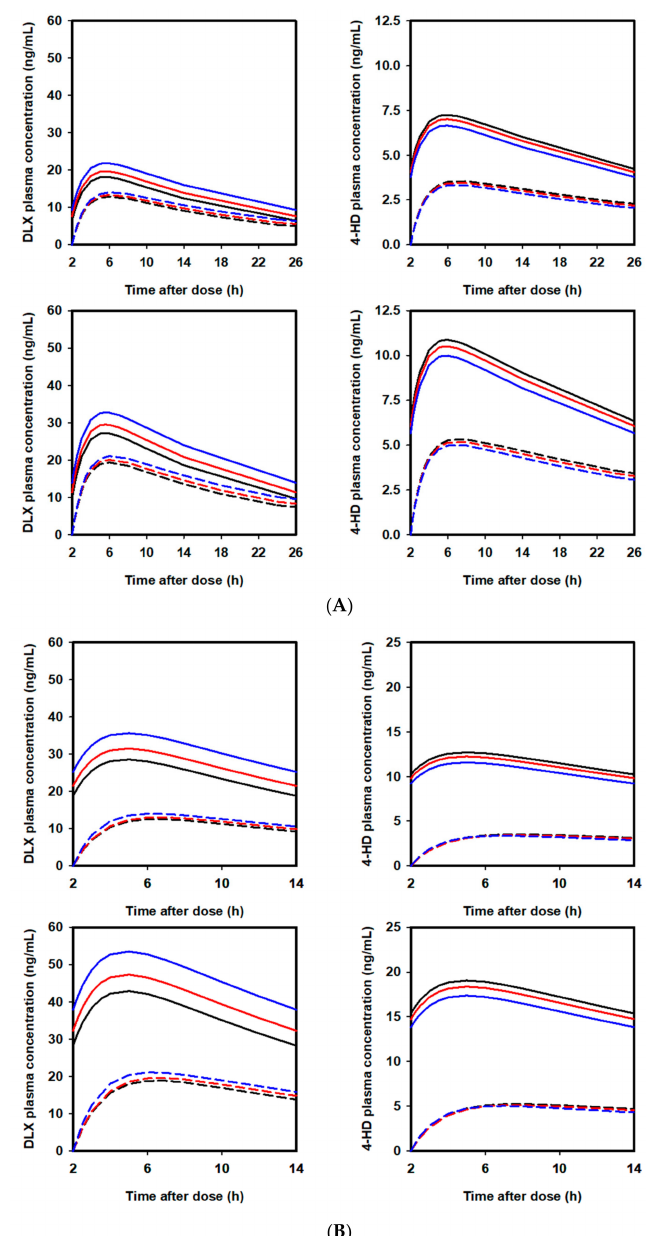
Figure 6. ( A ) Extrapolated concentration-time curve profiles of DLX and 4-HD at the first dosing interval (dashed line) and at the steady-state condition (solid line) following multiple DLX doses given once daily according to di ff erence doses of PPL in humans: (black) PPL 0 mg, (red) PPL 5000 mg, and (blue) PPL 15,000 mg. (Upper) 40 mg and (lower) 60 mg; ( B ) Extrapolated concentration-time curve profiles of DLX and 4-HD at the first dosing interval (dashed line) and at the steady-state condition (solid line) following multiple DLX doses given twice daily according to di ff erence doses of PPL in humans: (black) PPL 0 mg, (red) PPL 5000 mg, and (blue) PPL 15,000 mg. (Upper) 40 mg and (lower) 60